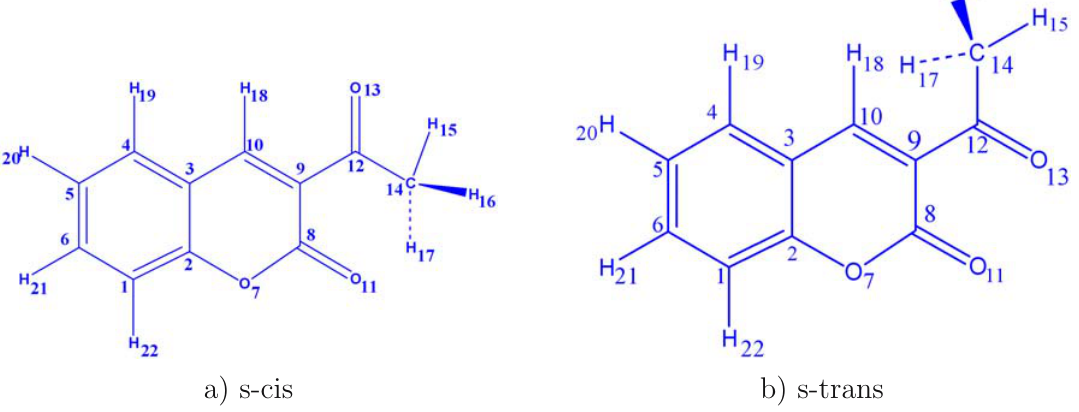
Fig. 1 The conformers considered and numbering of atoms of acetyl coumarin: (a) stable S- cis conformation and (b) S-trans